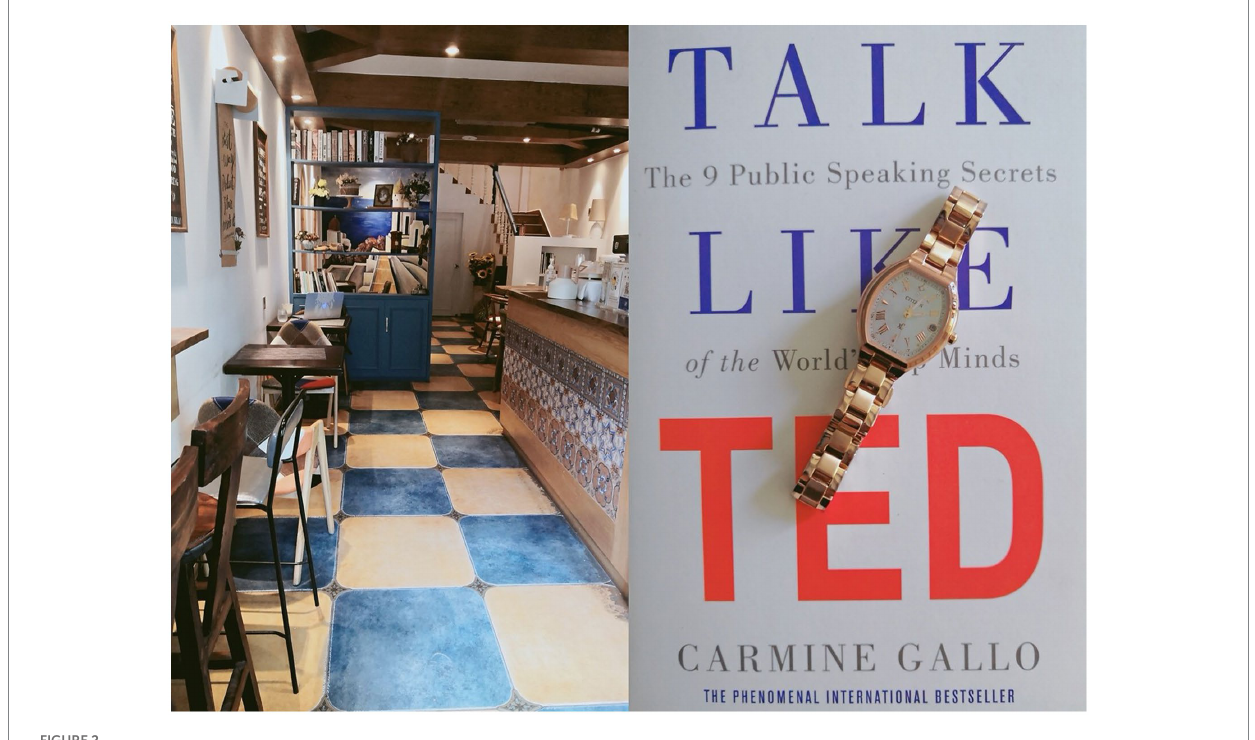
FIGURE 2 Huang’s photos (a local café and her